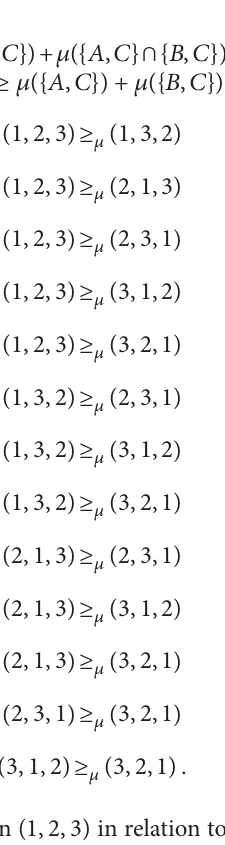
Figure 2: CI-Fairness relation among six possible allocations. The connections include